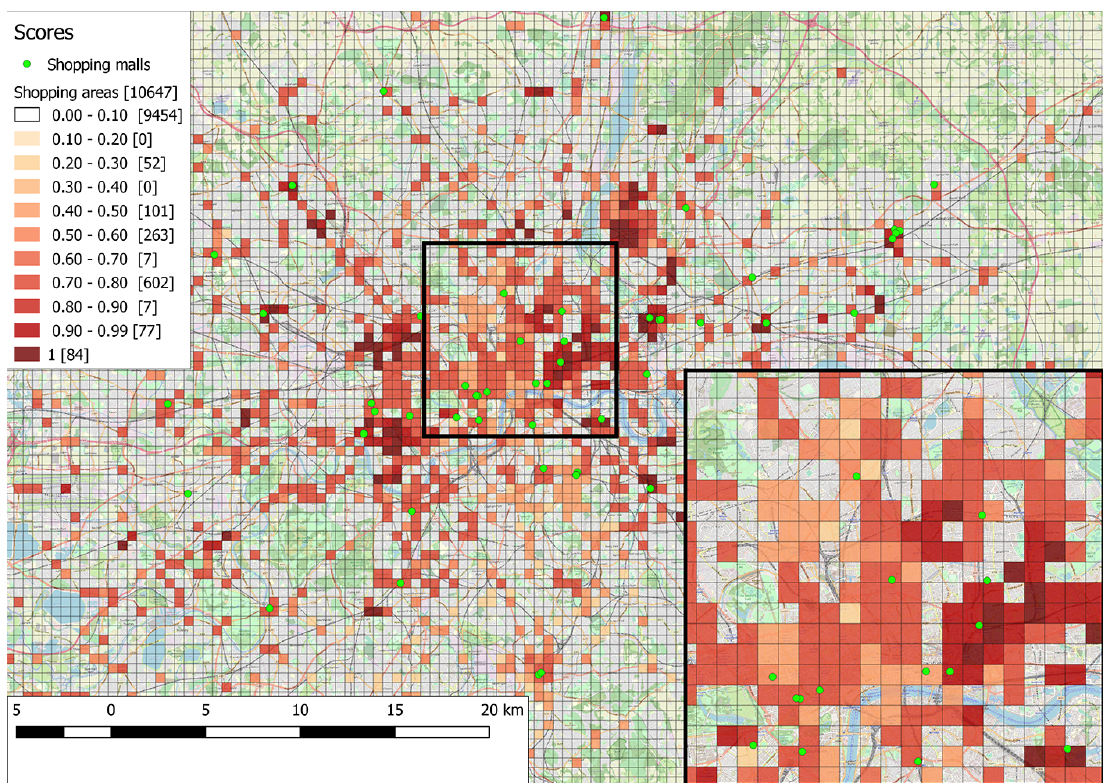
Figure 6. Results using probabilistic